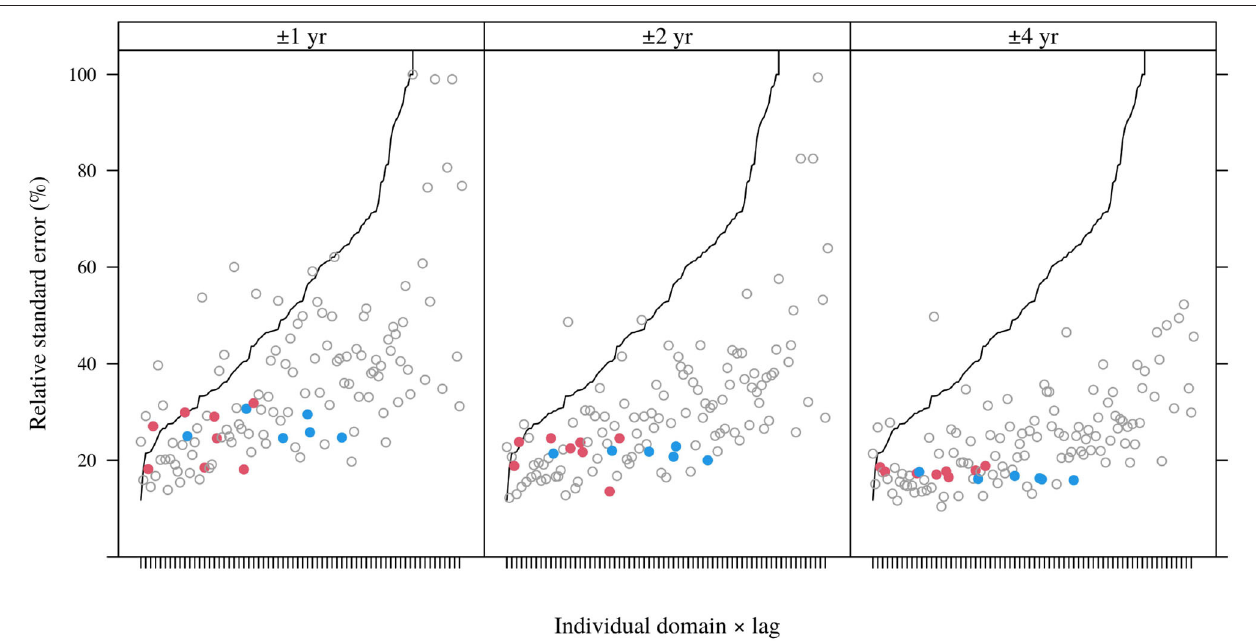
FIGURE 7 | Estimated relative standard errors of augmented sample means for 10-year domains (all lags) under for different temporal buffers; domains and lags are ordered according to relative standard errors of domain means (represented by the black curve). Horizontal axis labels are individual domain and lag identities and have been suppressed for clarity.